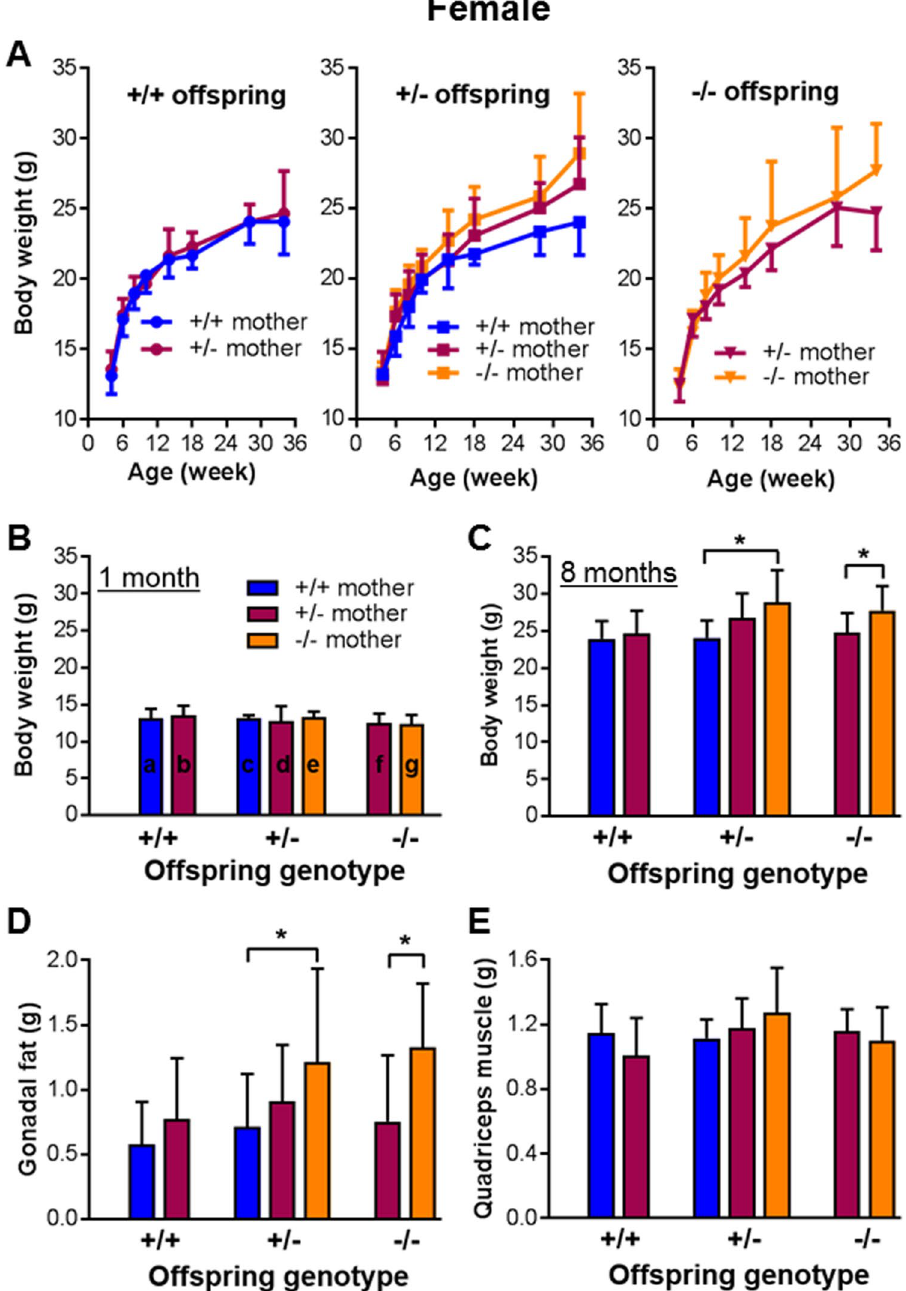
Figure 4. The impact of HtrA3 gene deletion in the mother versus fetus on postnatal body weight and organ weight in the female offspring. Female mice of three HtrA3 genotypes were crossed with HtrA3 + / − males as shown in Fig. 2A, and the resulting mice were monitored postnatally. The data from female offspring were analyzed according to their genotype as well as the genotype of their mothers, and are presented in the same format as Fig. 2D. ( A ) Body weight change over the period of 34 weeks. ( B , C ) Comparison of body weight across all 7 groups at one ( B ) and eight ( C ) months of age respectively. ( D , E ) Weight of gonadal fat ( D ) and quadriceps muscle ( E ) at eight months of age. The numbers of mice examined for each group (similar across A– E ): a, n = 19; b, n = 9; c, n = 11; d, n = 13; e, n = 11; f, n = 9; g, n = 8. The labelling of a-g is shown on the graph of ( C ) only. Data are expressed as mean ± SD. * p <